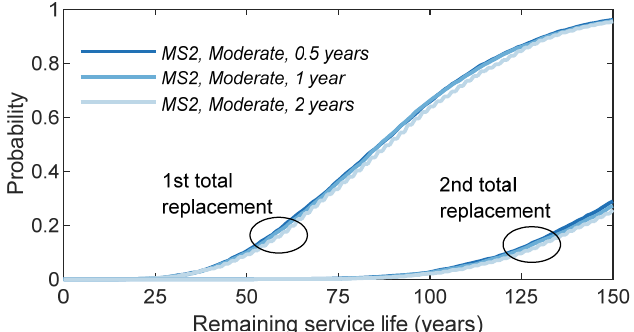
Figure 9. Cumulative distribution functions associated with the total replacement for the three inspection frequencies.